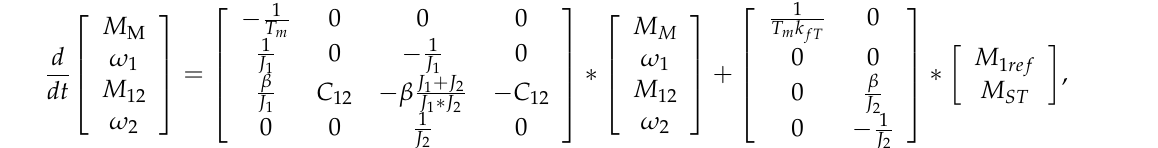
Figure 6. Two-mass system model: ( a ) for observer development; ( b ) as a matrix: M RT is the target torque of the motor. Matrix structure in Figure 6b corresponds to the state space